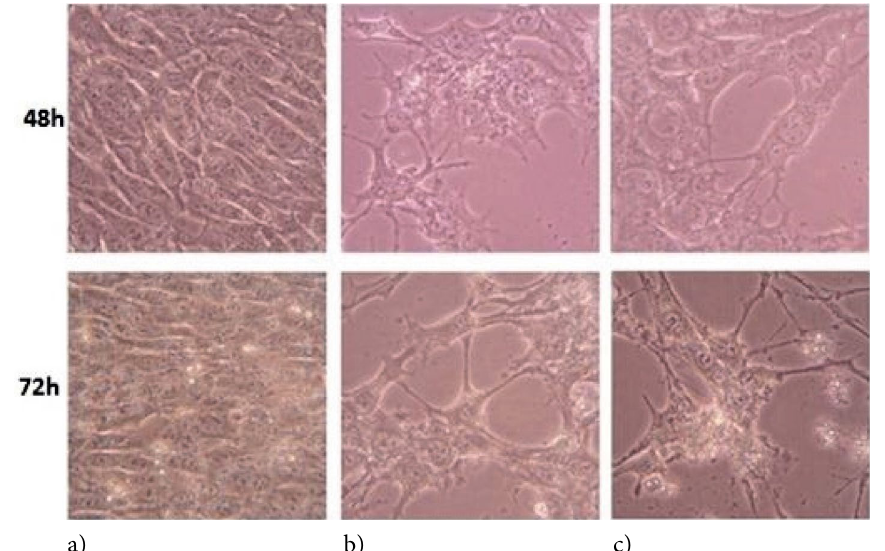
Figure 3. Morphological changes in the HeLa cells. HeLa cells were treated with A-UE (0.098 mg/mL) and A-SE (0.079 mg/mL) for 48 and 72 h. Native photographs are taken by the inverted microscope Olympus 1X51 with Olympus SP-500 UZ camera. Follows: a) control cells; b) A-UE extract and c) A-SE extract. Magnification 400 x.